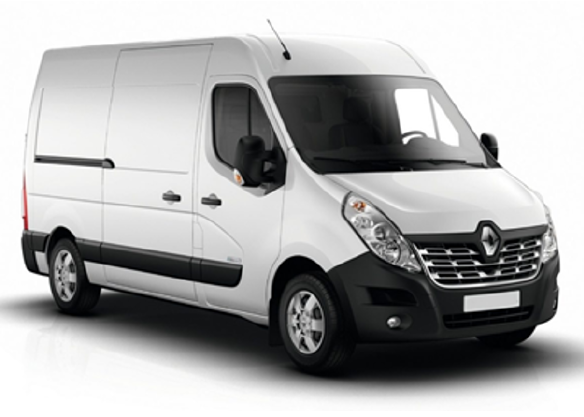
Figure 3: Variant solution D6 – Renault Master